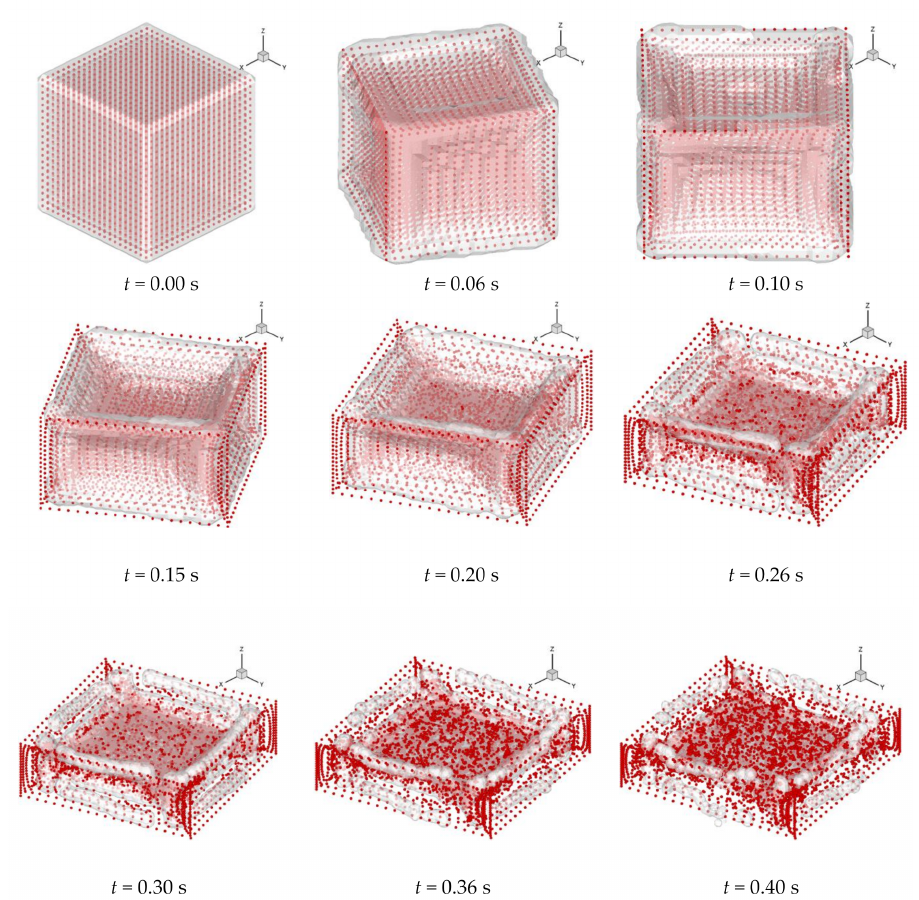
Figure 10. Deformation process comparison between Case 4 of the MPS method (red points) and the VOF (grey